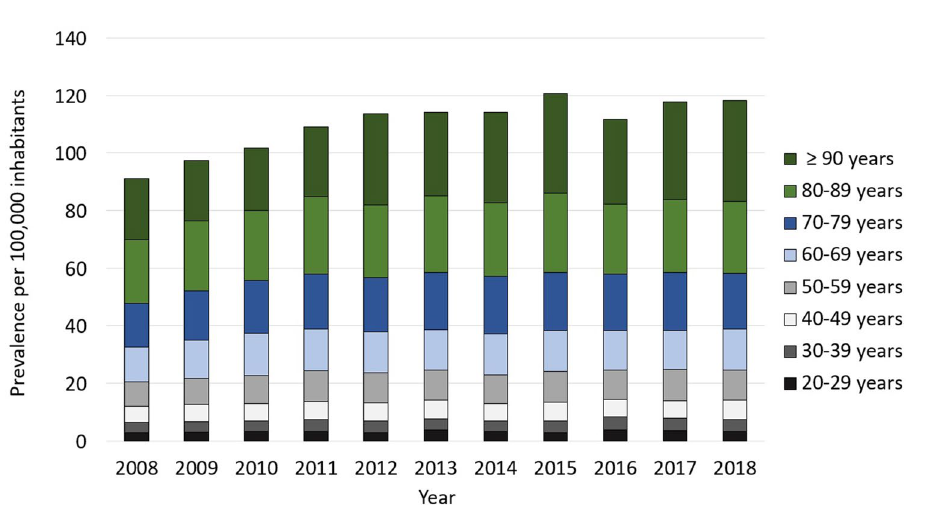
Figure 2. Development of FRI prevalence from 2008 to 2018 as a function of age group in 10-year